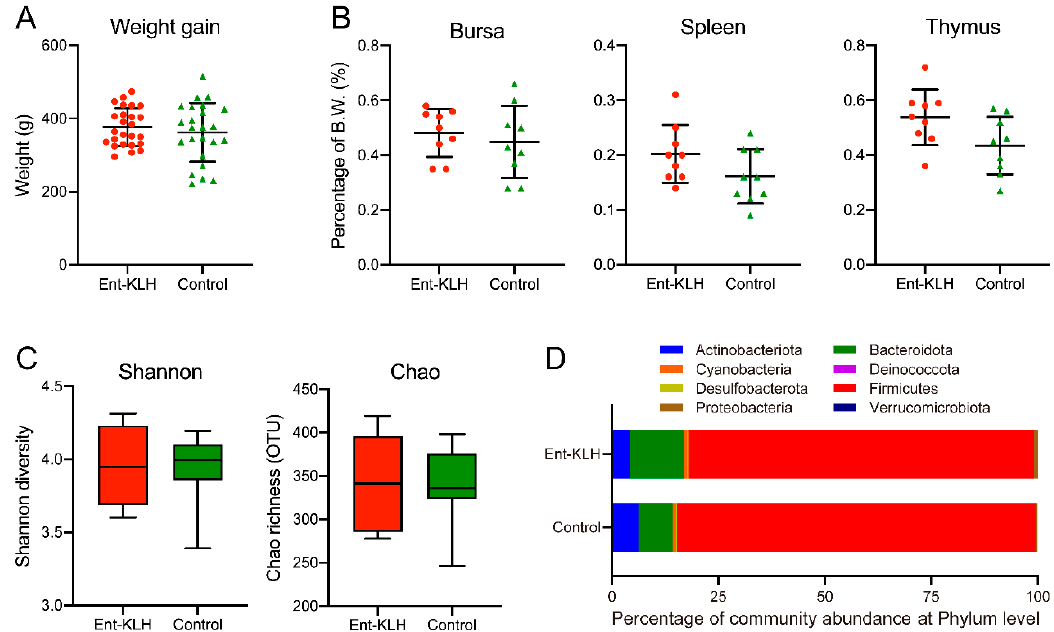
Figure 2. Effects of vaccination of chickens with the Ent–KLH conjugate on growth performance, immune organ development, and gut microbiota. ( A ) Chicken body weight gain. Each symbol represents the body weight gain of each individual chicken between ages of 7 and 49 days. ( B ) The weight percentage of each immune organ (bursa, spleen or thymus) to its body weight at 49 days old. ( C ) The Shannon diversity and the Chao richness (OTU) based on 16S rDNA amplicon sequences of the cecal samples. ( D ) Relative abundance of the eight dominant phyla in the cecum between Ent–KLH and PBS-control groups.